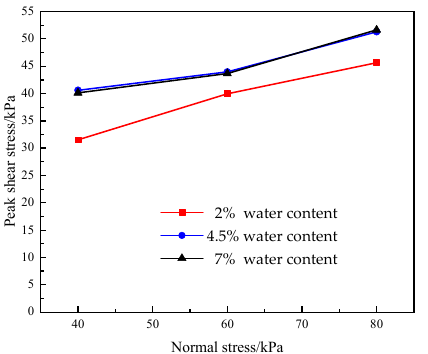
Figure 12. The relationship curve between the shear strength and normal stress of the reinforced soil interface under the freezing state ( − 5 °C).